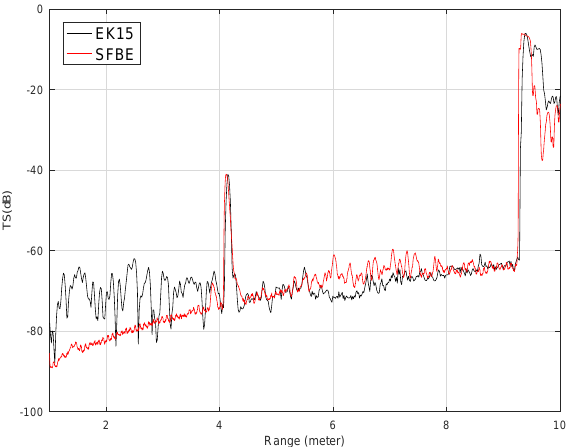
Figure 15. Average TS calculated for the depth range between 1 m to 10 m when the 36.4 mm sphere was at 4 m. The red graph is for SFBE and the black is for EK15.